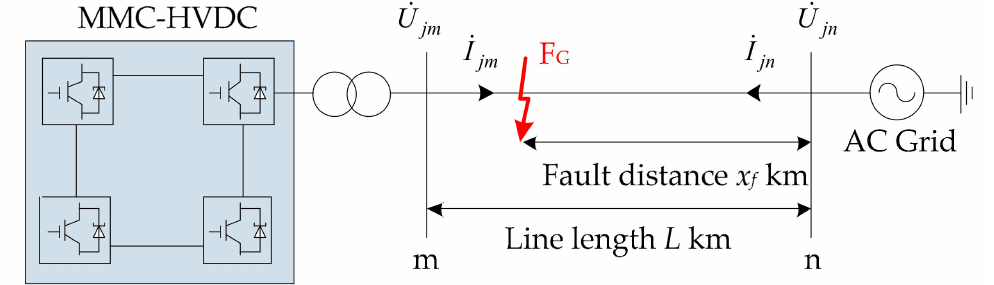
Figure 1. Model of a MMC-HVDC-based AC/DC hybrid